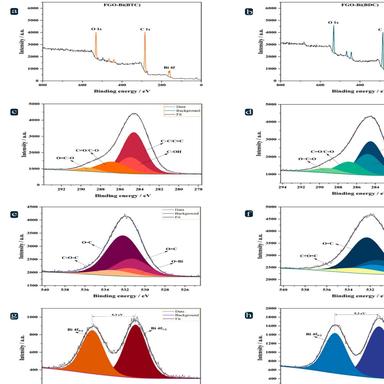
The XPS spectra of FGO-Bi(BTC) and FGO-Bi(BDC): a and b) survey, c and d) C 1s, e and f) O 1s, and g and h) Bi 4f.